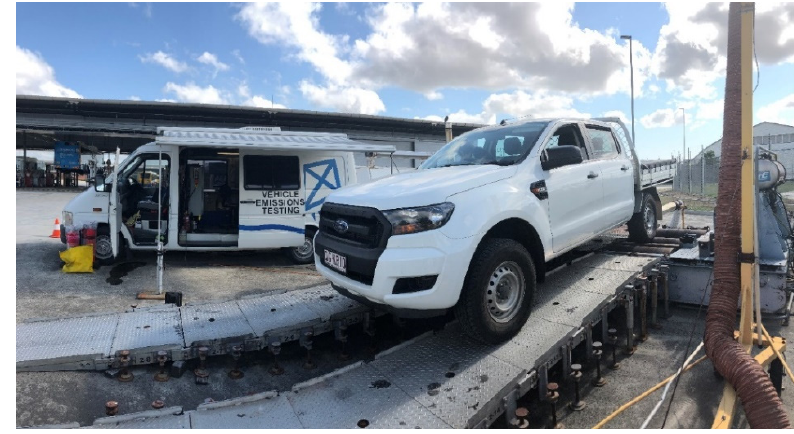
Figure 2. RSD test route at the commercial RSD site.